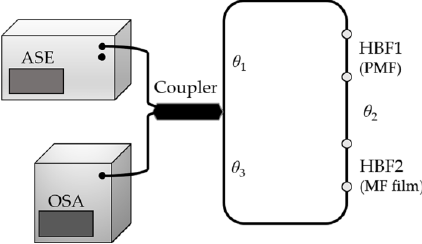
Figure 21. Schematic diagram of a Loyt–Sagnac interferometer (adapted from [66]).